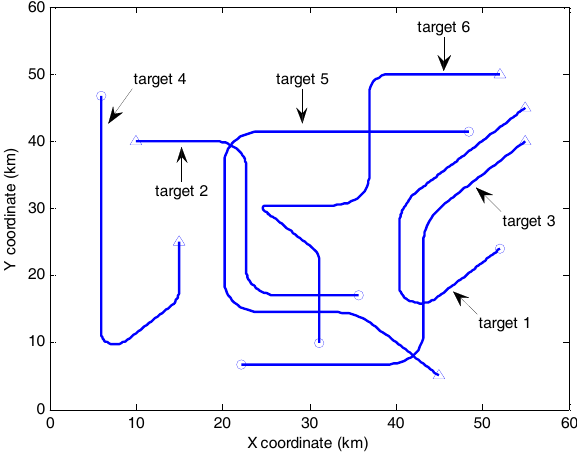
Figure 11. Trajectories in Cartesian coordinates with start and stop positions denoted by (cid:4574) and ○ .